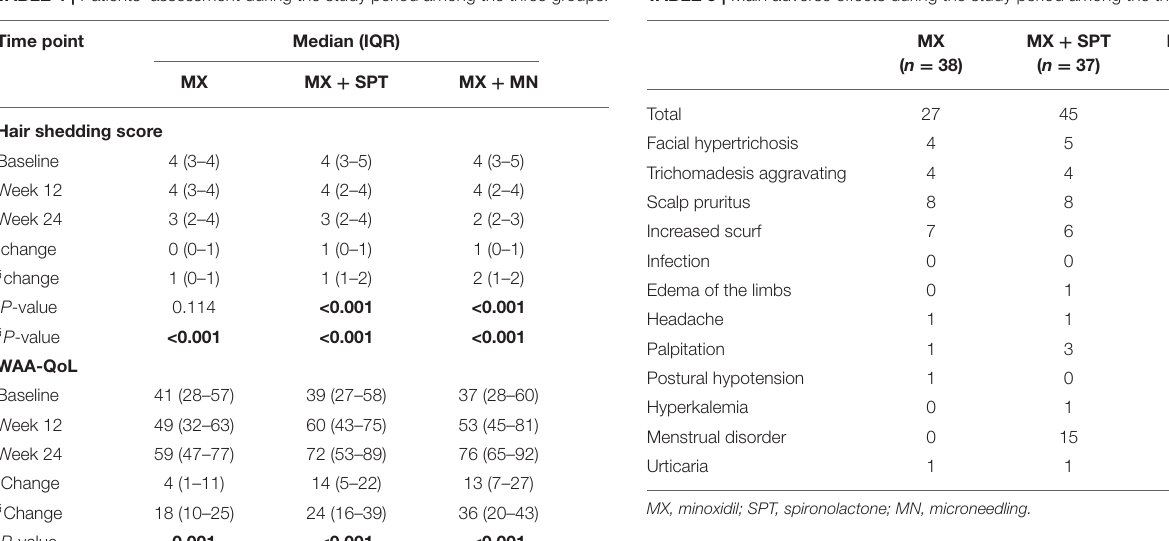
TABLE 4 | Patients’ assessment during the study period among the three groups. TABLE 5 | Main adverse effects during the study period among the three